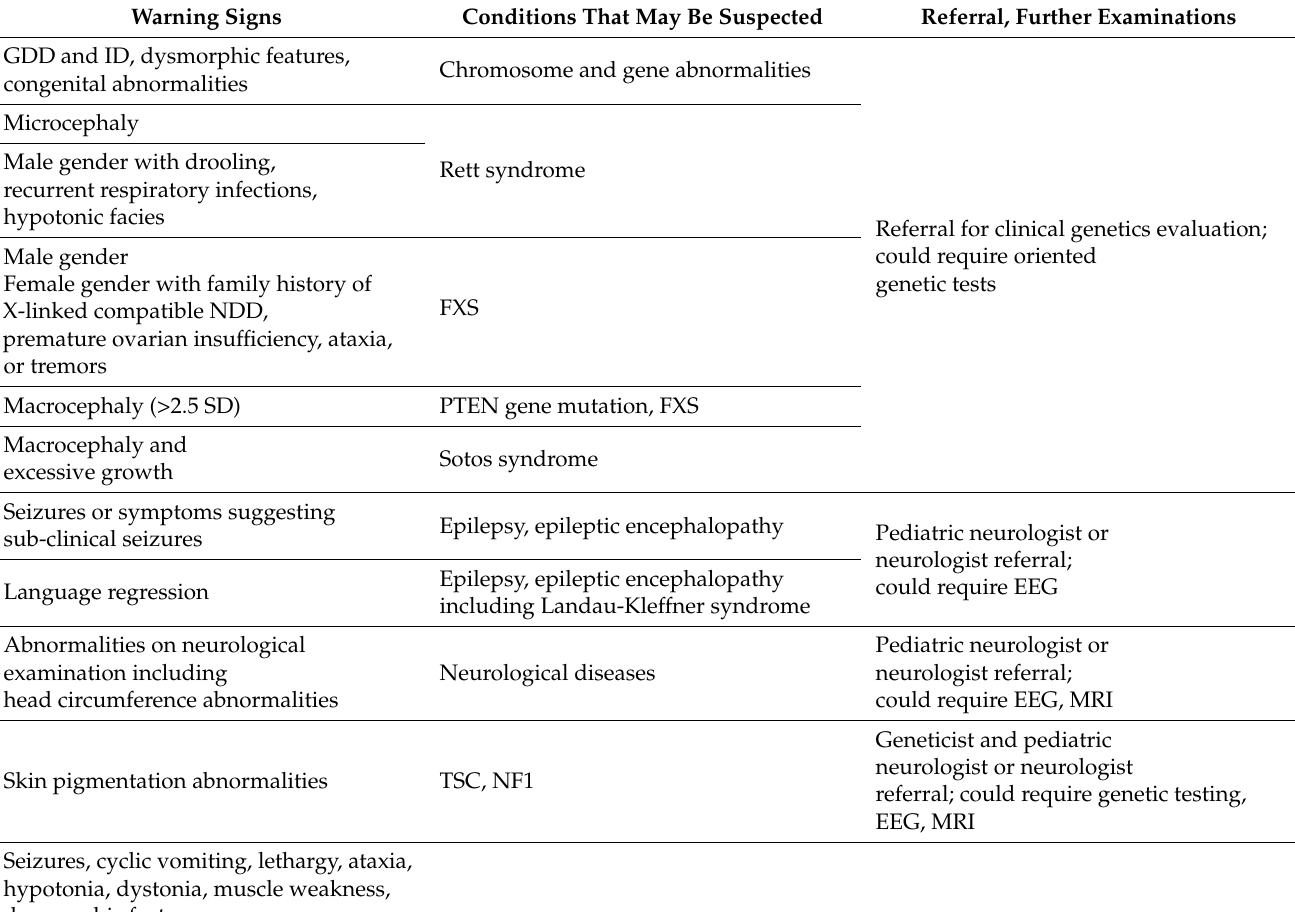
Table 4. Warning signs for co-occurring somatic conditions in the ASD population and the referrals and further examinations